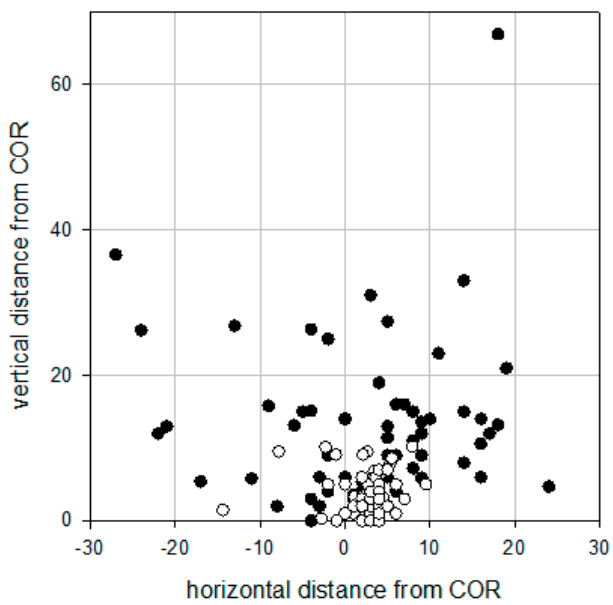
Figure 7. Scatter plot demonstrating the location of the center of rotation pre- (black dots) and postoperatively (white dots). The point of origin (0/0 mm) represents the aCOR.